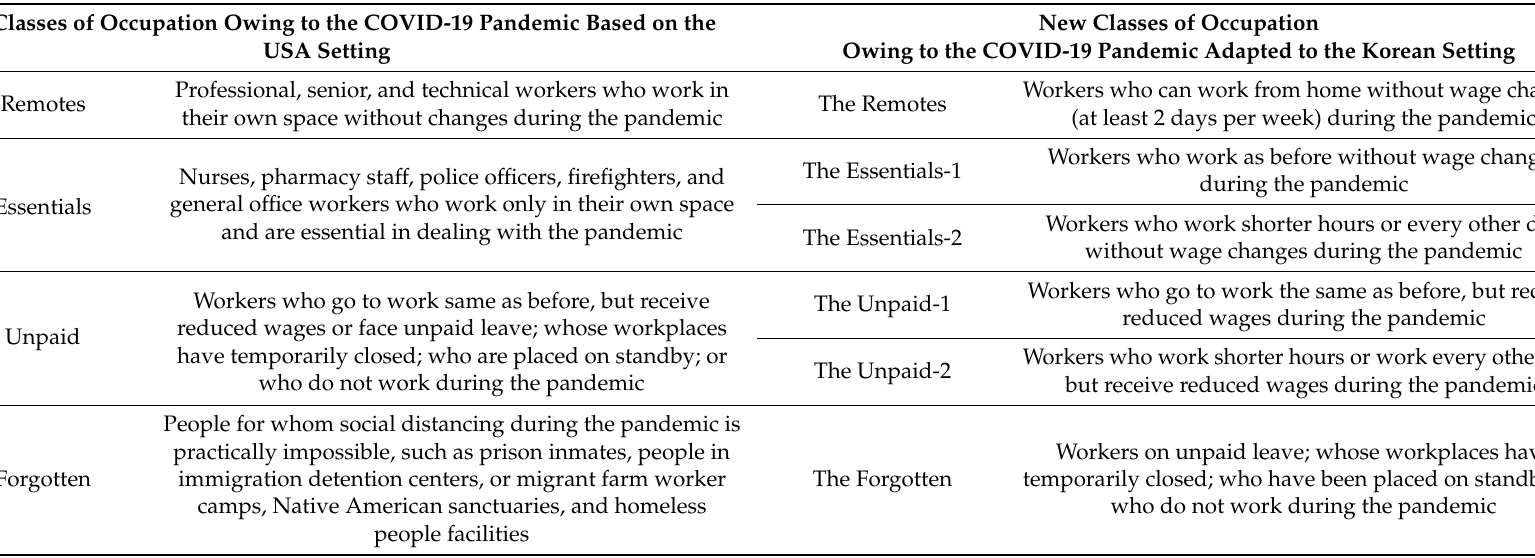
Table 1. Di ff erences between the new classification of the occupations owing to the COVID-19 pandemic (as proposed by Reich [4], based on the United States of America context) and the adapted classifications proposed for the Korean